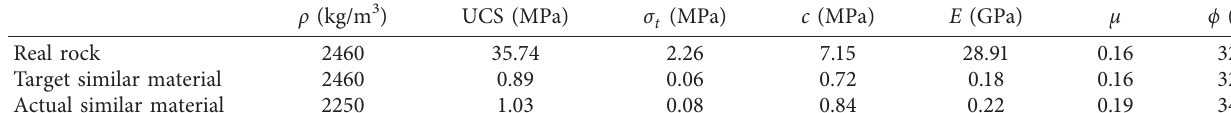
Figure 4: Similar materials. (a) Components of similar materials and (b) standard specimens of different proportions. Table 1: Physical and mechanical parameters of the real rock and the analogue materials.